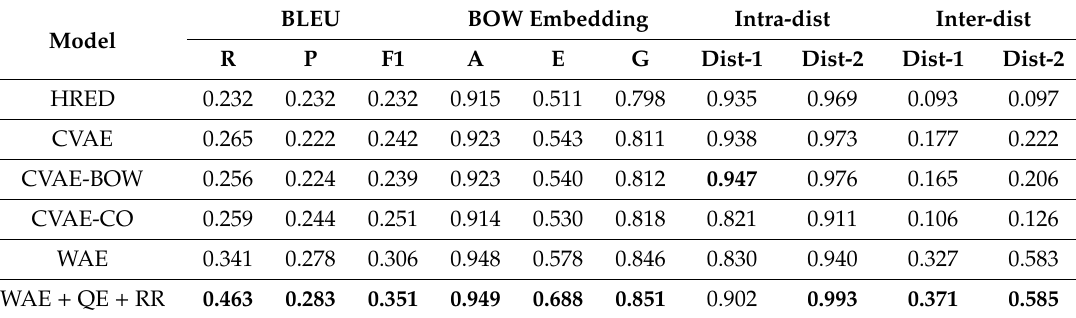
Table 3. Performance comparison between proposed and previous